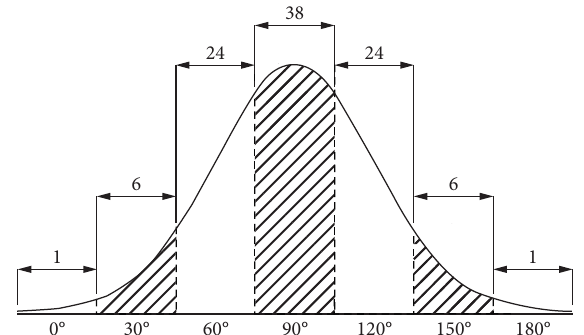
Figure 11: Te distribution of the amount of damage data in each fow